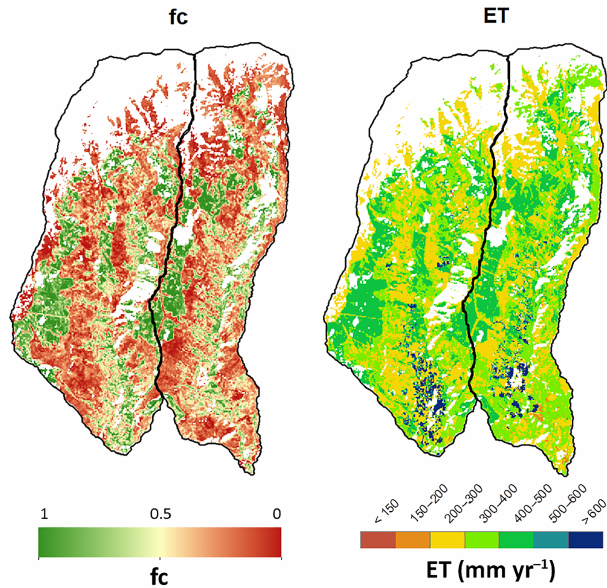
Figure 1. Distributed average values of f c and annual estimated ET values for the hydrological year